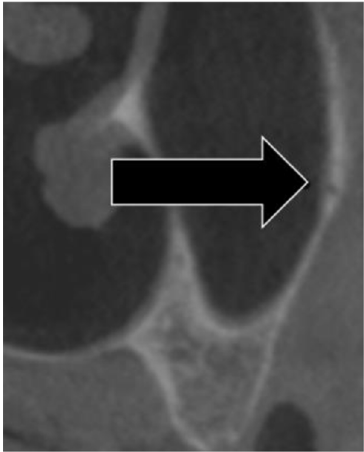
Fig. 3. Outer cortex of lateral sinus wall variety of PSAA.